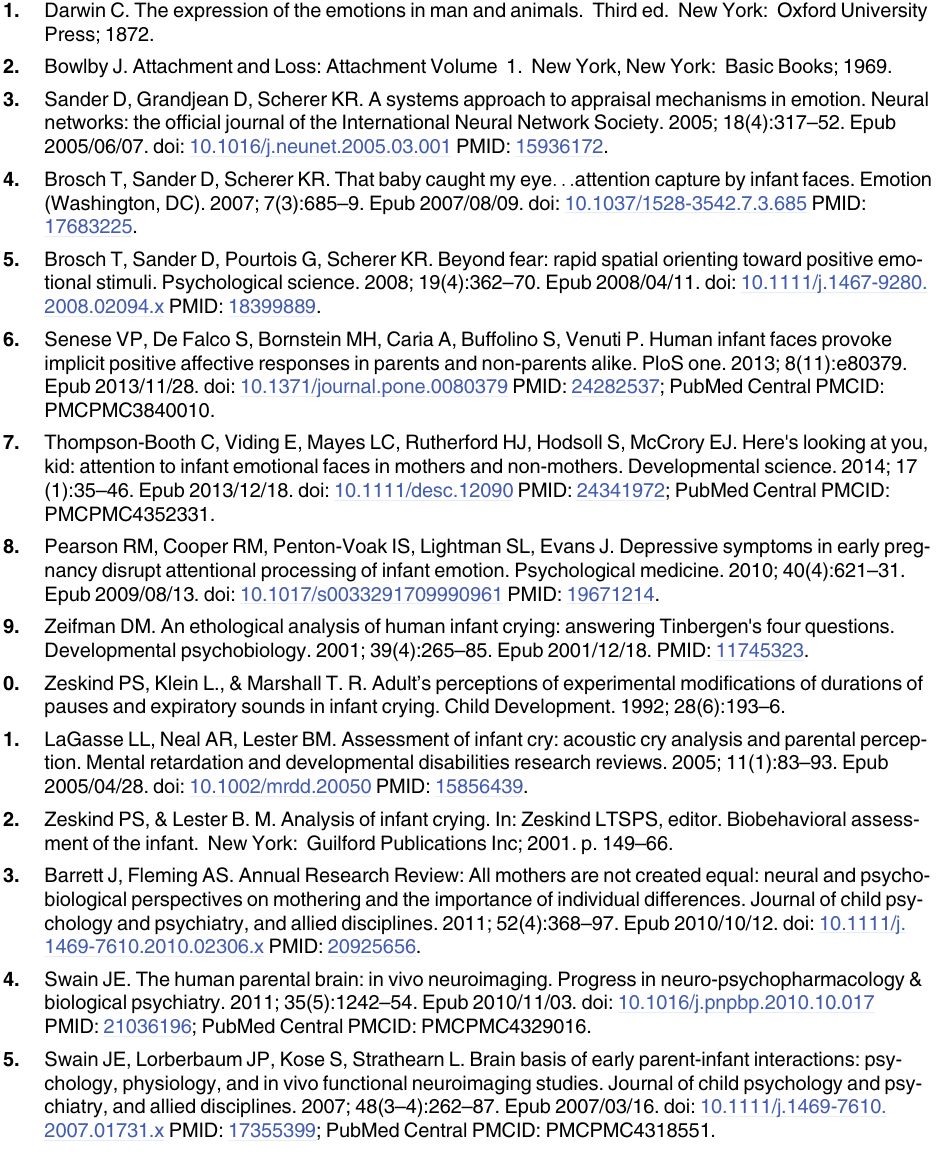
S2 Table. Data set from Experiment